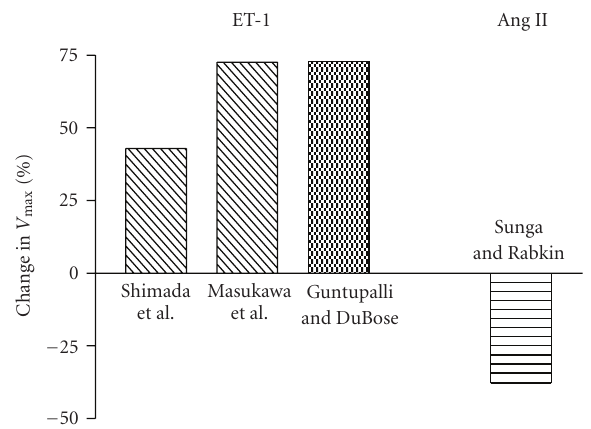
Figure 3: The e ff ect of endothelin I (ET-1) and angiotensin II (Ang II) on the kinetics of phosphate uptake V max in various